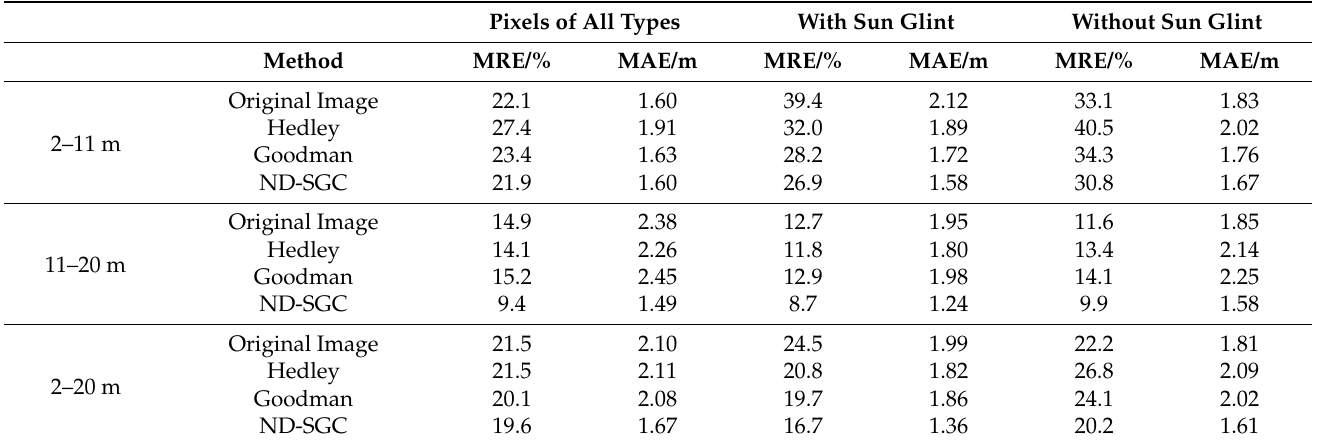
Table 4. Evaluation of bathymetric inversion accuracy of the Log-Linear model for Sentinel-2 image